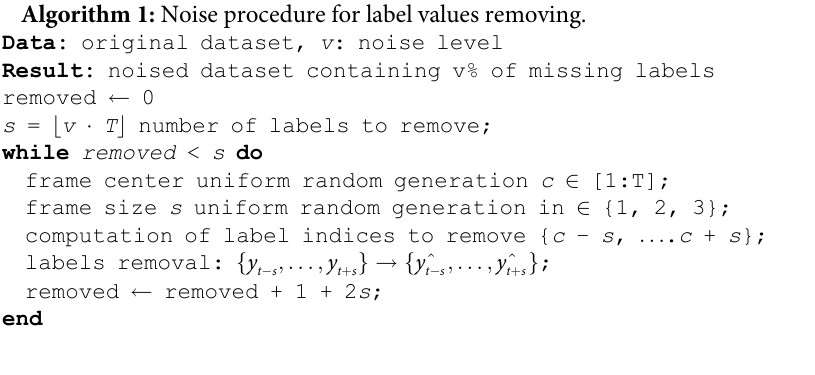
Algorithm 1: Noise procedure for label values removing.